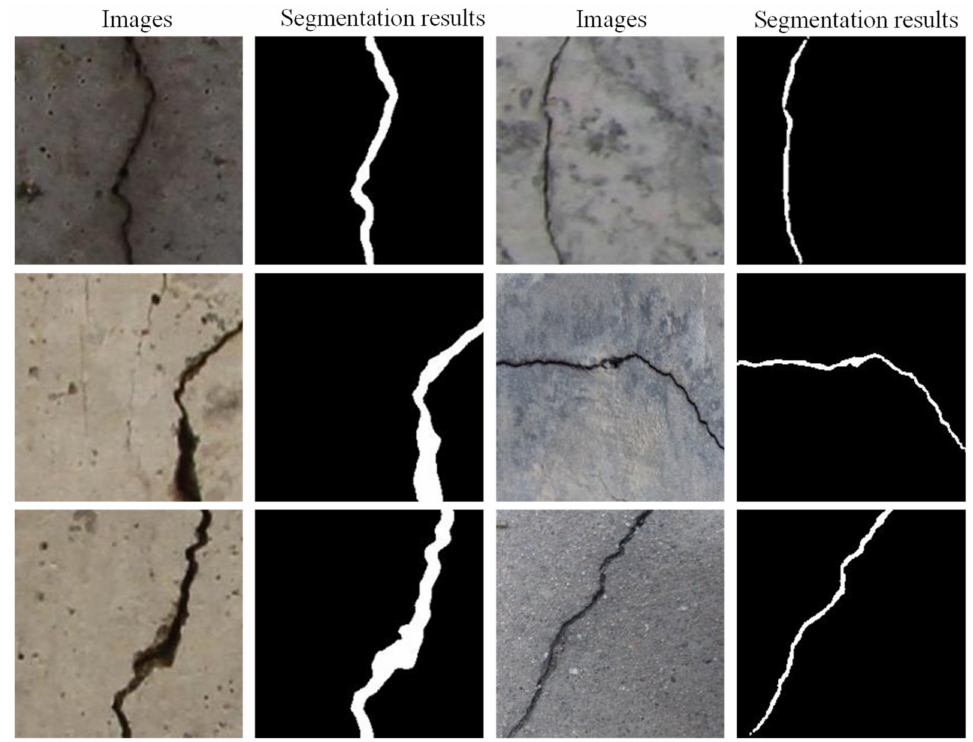
Figure 11. The demonstration of the identification effect of the proposed method on different types of